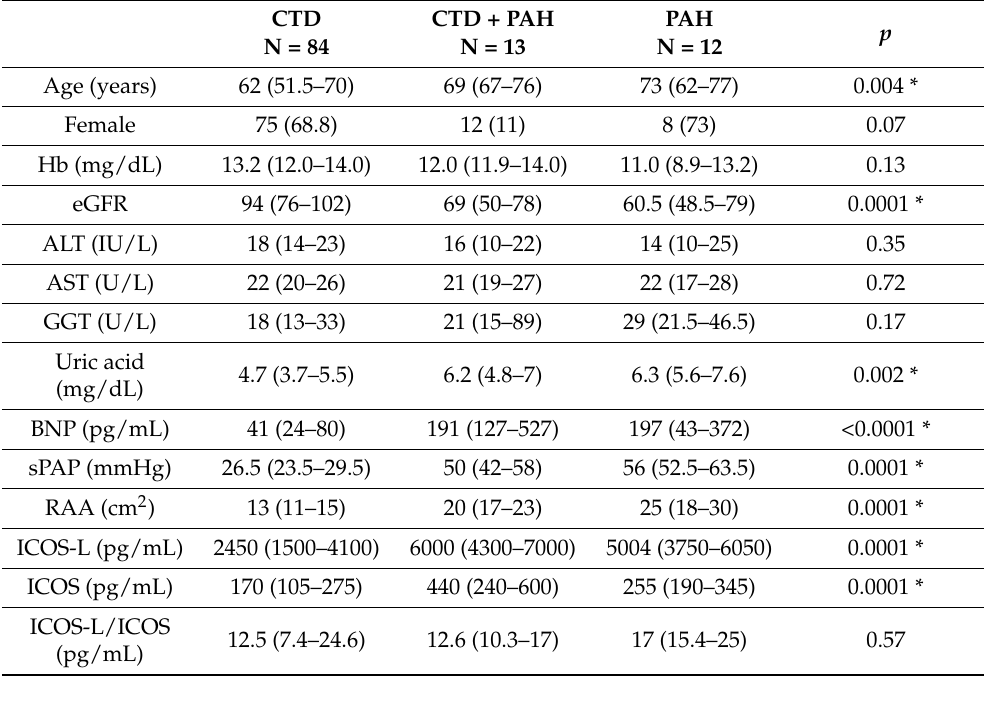
Table 1. General characteristics of study population groups. The table shows the main demographic features, frequencies, and percentage of main parameters in the 3 study population groups. Cate- gorical variables are shown as frequencies (%), while continuous variables are shown as medians and interquartile range (IQR). Abbreviations: CTD: connective tissue disease; PAH: pulmonary arterial hypertension; Hb: hemoglobin; eGFR: estimated glomerular filtration rate; ALT: alanine aminotransferase; AST: aspartate aminotransferase; GGT: gamma glutamyl transferase; sPAP: systolic pulmonary artery pressure; RAA: atrium area; ICOS: inducible co-stimulator; ICOS-L: inducible co-stimulator ligand. * = CTD vs. CTD + PAH and PAH.